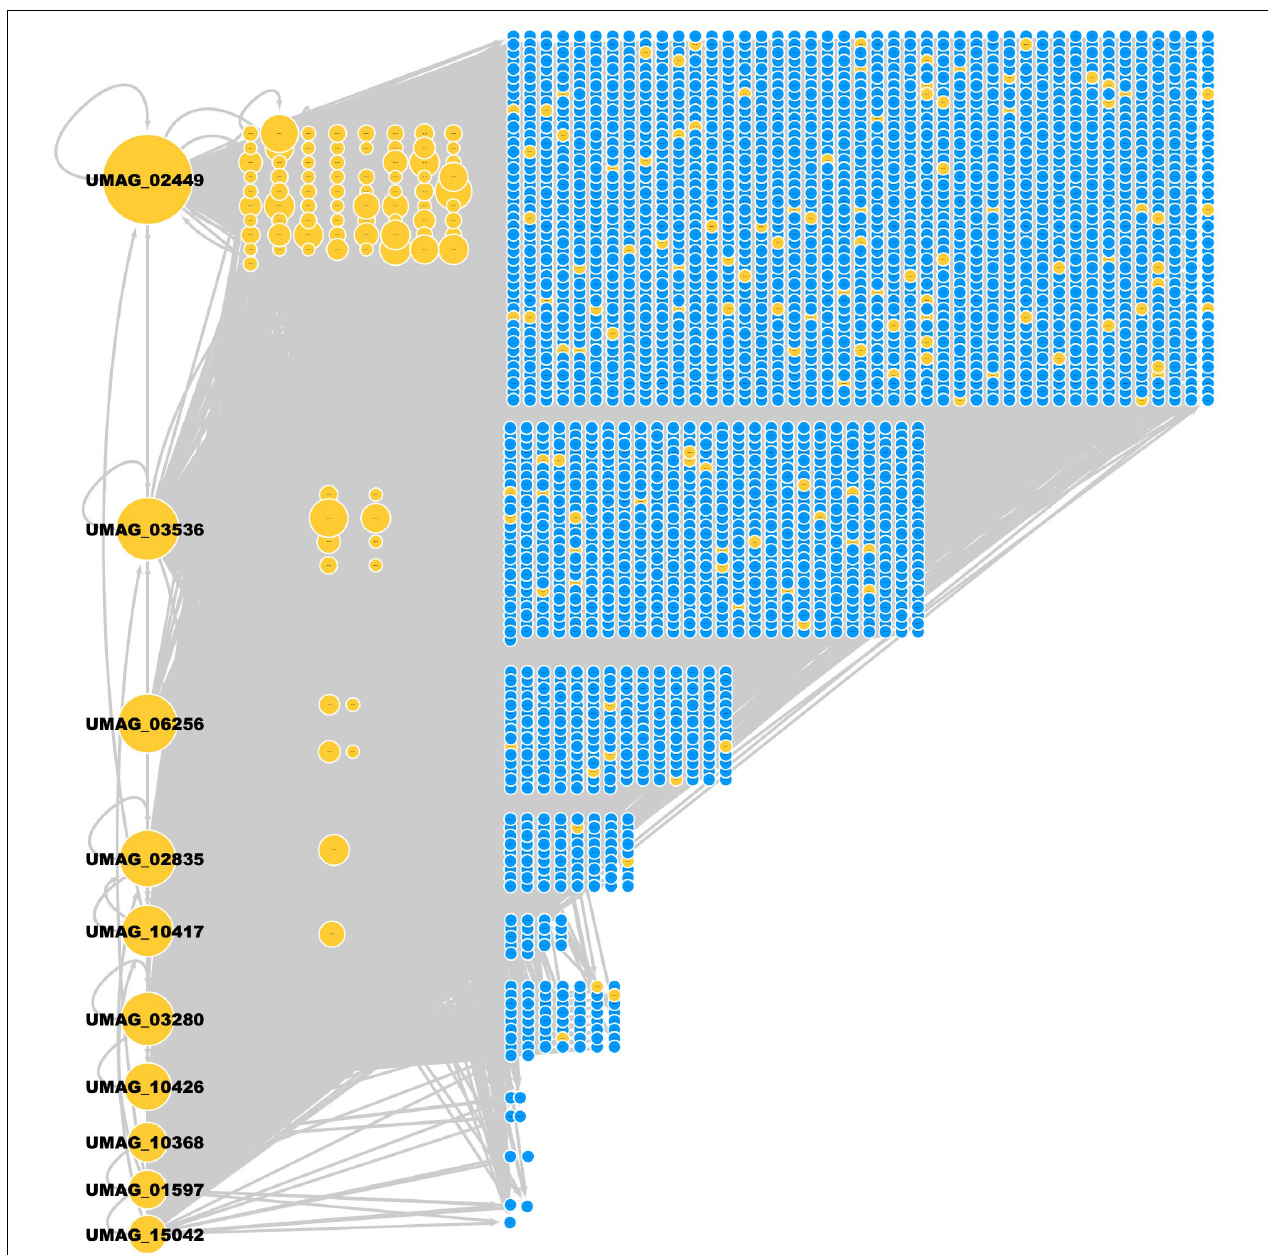
FIGURE 2 | GRN of U. maydis . TFs (yellow nodes) and TGs (blue nodes). The most connected TFs (nodes) are UMAG_02449 (BHLH domain-containing protein), UMAG_03536 (hypothetical protein), UMAG_06256 (Zn(2)-C6 fungal-type domain-containing protein), UMAG_02835 (hypothetical protein), UMAG_10417 (hypothetical protein), UMAG_03280 (hypothetical protein), UMAG_10426 (pH-response TF pacC), UMAG_10368 (hypothetical protein), UMAG_01597 (Uncharacterized protein), and UMAG_15042 (Cell pattern formation-associated protein